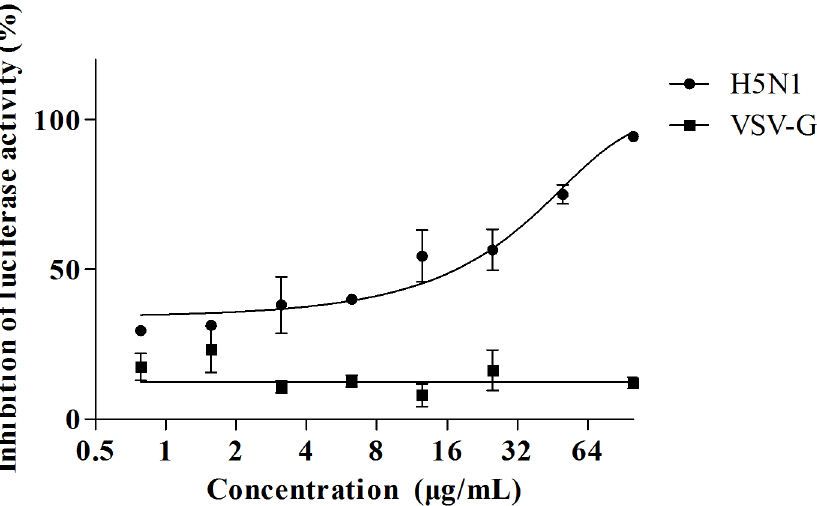
Fig 3. The inhibitory effect of HA-FP-1 toward VSV-G and H5N1 pseudoviruses was compared at various concentrations. MDCK cells (1 × 10 4 /well) were seeded in 96-well plates and incubated overnight. After removal of culture supernatants, 100 μ L of fresh cell culture medium was added into the plate. The peptides were serially two-fold diluted from 100 to 0.78 μ g/mL in culture medium and then incubated with equal volume of pseudo-typed particles at 37°C for 30 min. Subsequently, the same volume of virus-peptide mixture was transferred into the MDCK cells and incubated for 48 h at 37°C before performing luciferase